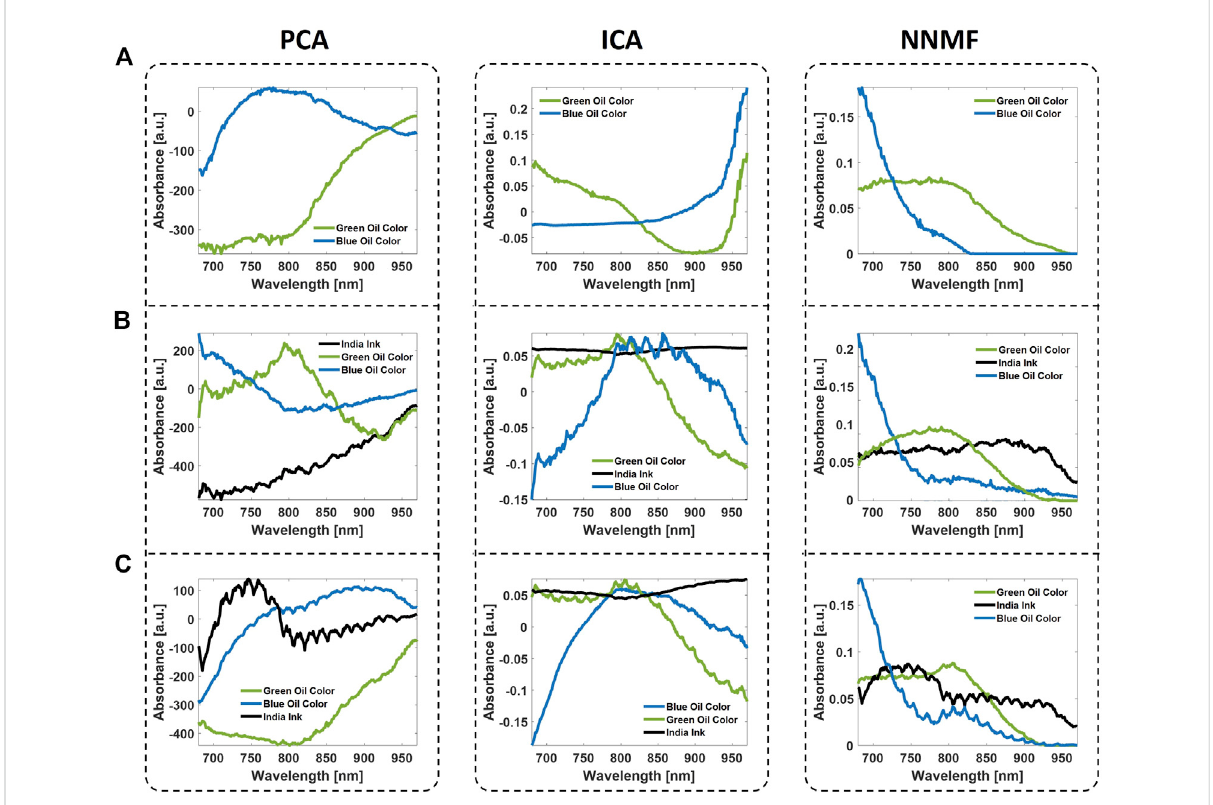
FIGURE 5 Unmixed spectra obtained from the vessel-mimicking phantoms with no background absorption (row (A) ), medium background absorption (row (B) ), and high background absorption (row (C) ). The unmixing has been performed by means of the BSS algorithms PCA, ICA, and